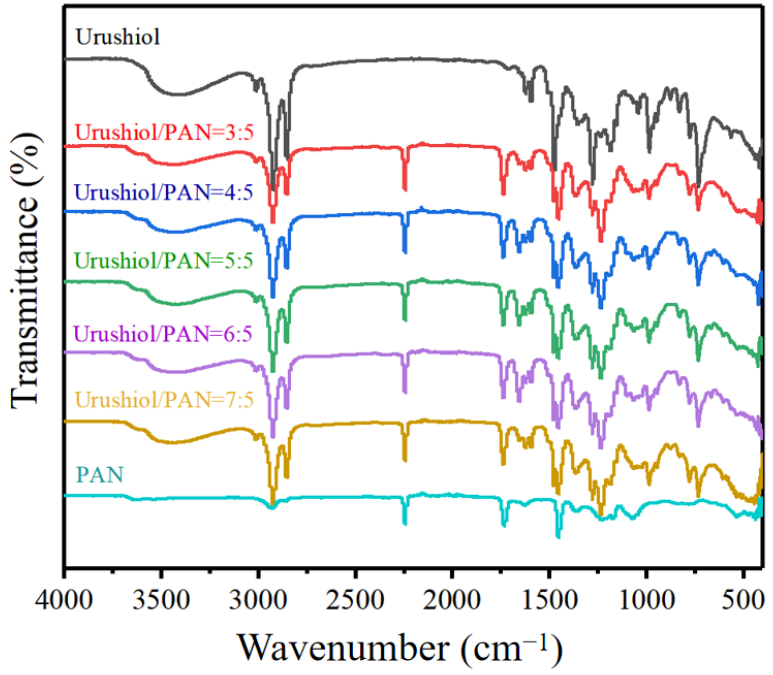
Figure 4. FT-IR spectra of urushiol/PAN nanofilms with different urushiol/ PAN mixing ratios.